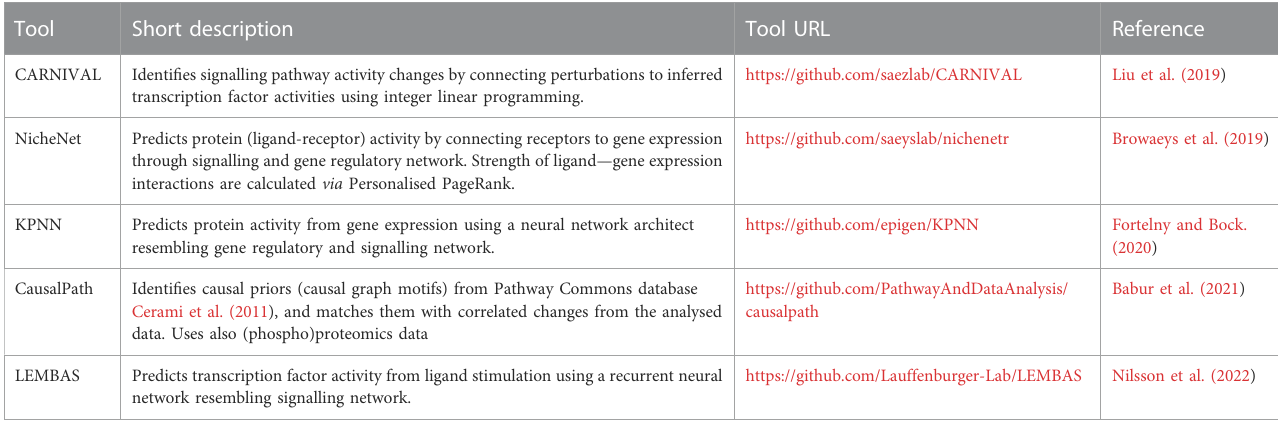
TABLE 3 Gene expression based mechanistic modells.